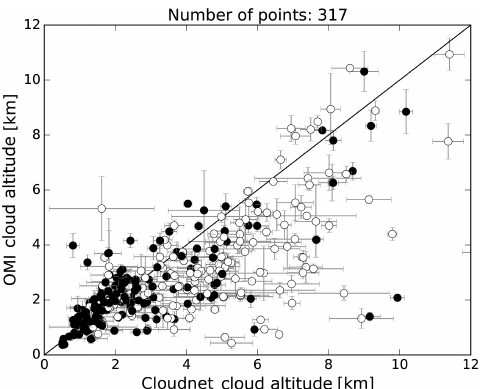
Figure 11. The retrieved effective cloud altitude from OMI, plotted as a function of the radar–lidar-derived cloud altitude. Closed sym- bols are for single-layer clouds; open symbols are for multi-layer